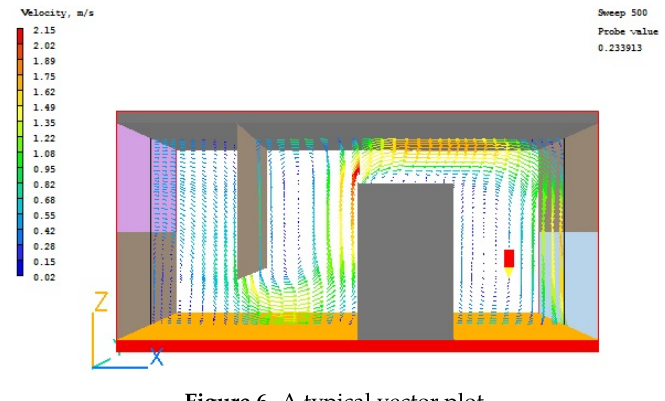
Figure 6. A typical vector plot.